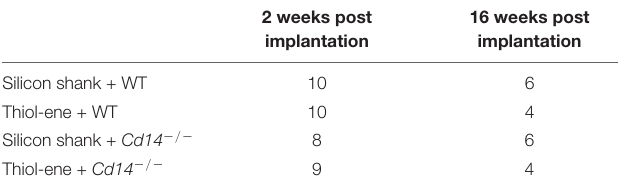
TABLE 1 | Number of experimental animals for each condition at each time